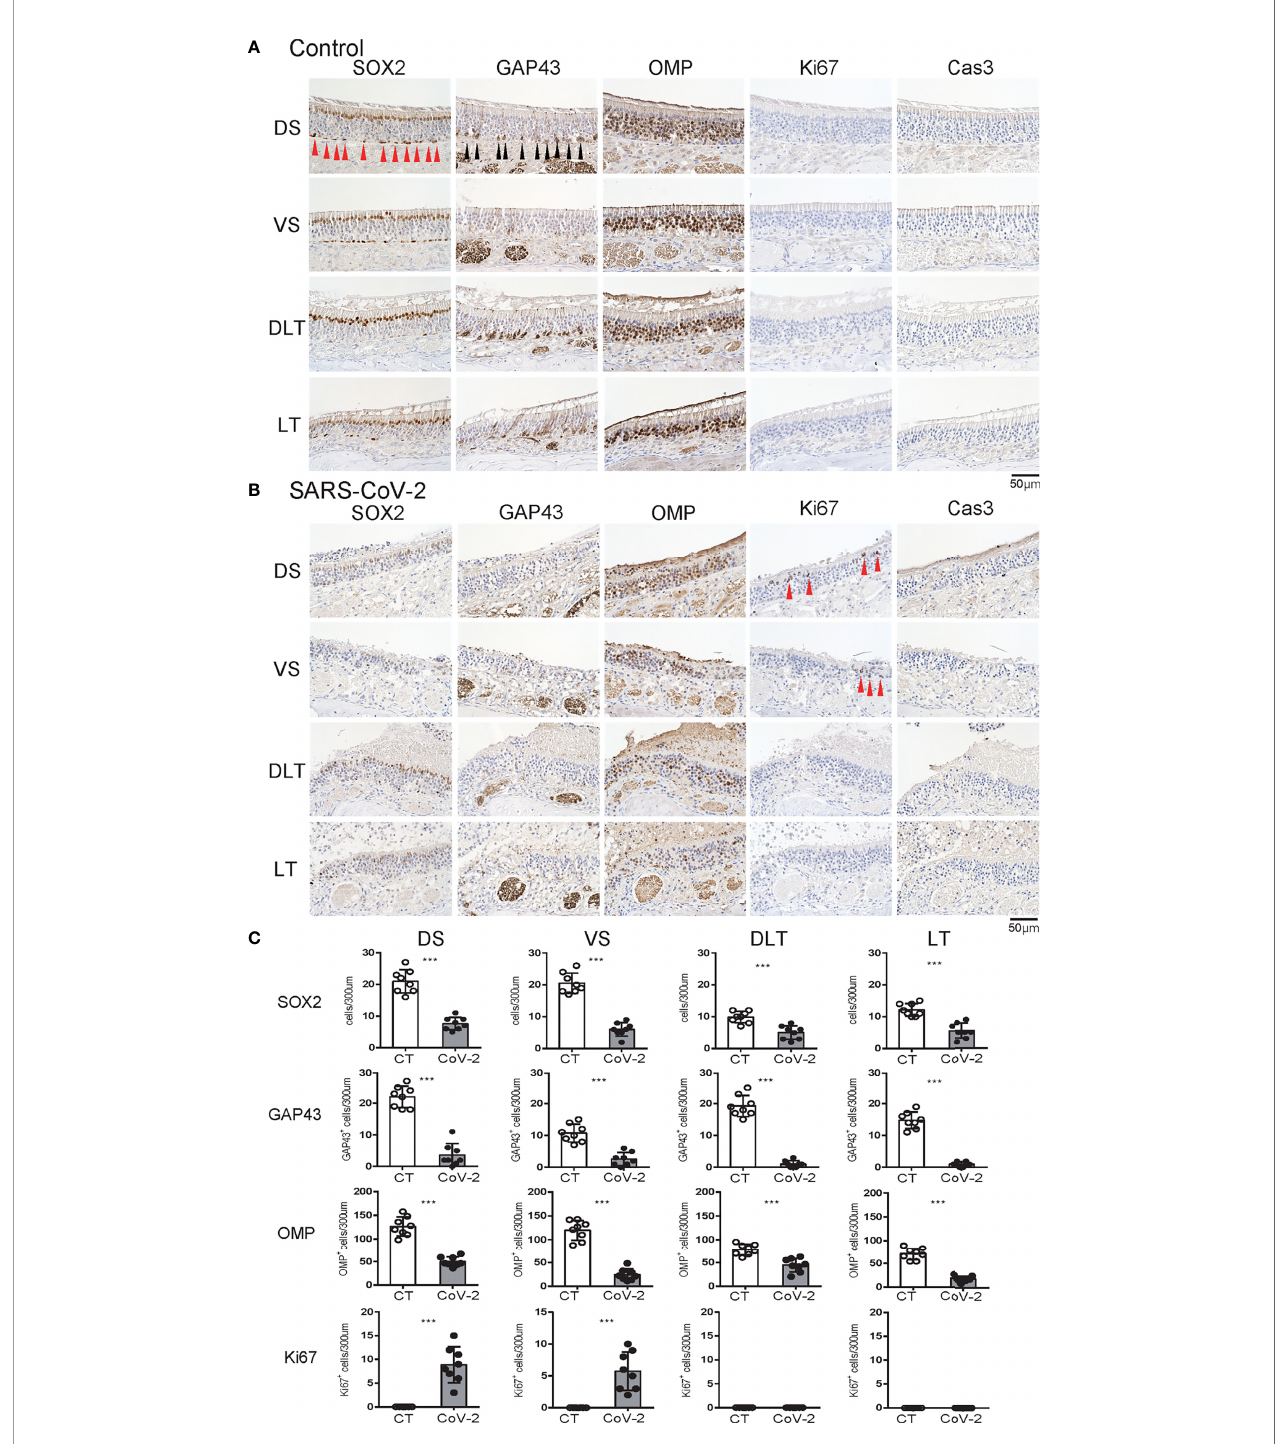
FIGURE 2 | Effects of SARS-CoV-2 infection on the olfactory receptor neuron lineage. (A, B) Representative images of immunohistological staining in control hamsters (A) and severe acute respiratory syndrome coronavirus 2 (SARS-CoV-2) hamsters (B) . Sex-determining region Y-box 2 (SOX2) + progenitor cells, growth- associated protein 4 (GAP43) + immature olfactory receptor neurons (ORNs), olfactory marker protein (OMP) + ORNs, Ki67 + proliferating cells, and cleaved caspase-3 (Cas3) + apoptotic cells are shown in brown. Each cell, except for the numerous OMP+ cells, is indicated by arrows. Tissue sections were counterstained with the nuclear dye hematoxylin (blue). (C) Numbers of SOX2 + ORN progenitors and Ki67 + actively proliferating cells per 300 m m of the basal layer and OMP+ mature ORNs, GAP43+ immature ORNs, and Cas3+ apoptotic cells per 300 m m of olfactory epithelium in each area are counted in control or SARS-CoV-2 hamsters. *** P <